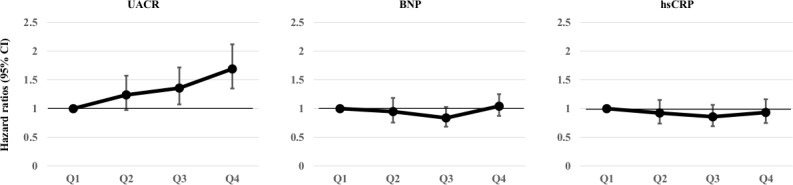
A time-dependent Cox regression analysis for the risk of LTC for each biomarker.Hazard ratios (95% confidence intervals) for the risk of LTC with each biomarker adjusted by age, sex, body mass index, systolic blood pressure, total cholesterol, high-density lipoprotein cholesterol, blood hemoglobin, HbA1c, eGFR, the duration of education, atrial fibrillation, smoking status, drinking status, and interim CVD. The solid line is the hazard ratio, the bar is the 95% confidence interval. The levels of quartiles for each biomarker are shown in Table 1 (see median and IQR).